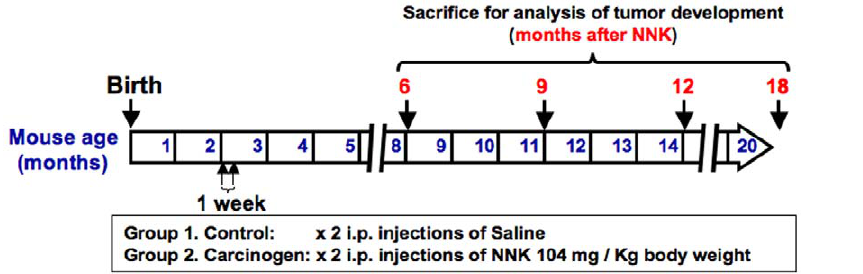
Figure 1. NNK-induced lung carcinogenesis in Gprc5a -knockout mice. Schematic illustration depicting the experimental plan where 2 months old Gprc5a -knockout mice were treated with 104 mg/kg body weight NNK or control saline intraperitonealy (i.p.) twice one week apart and followed up for lung lesion development at 6, 9, 12 and 18 months following treatment.